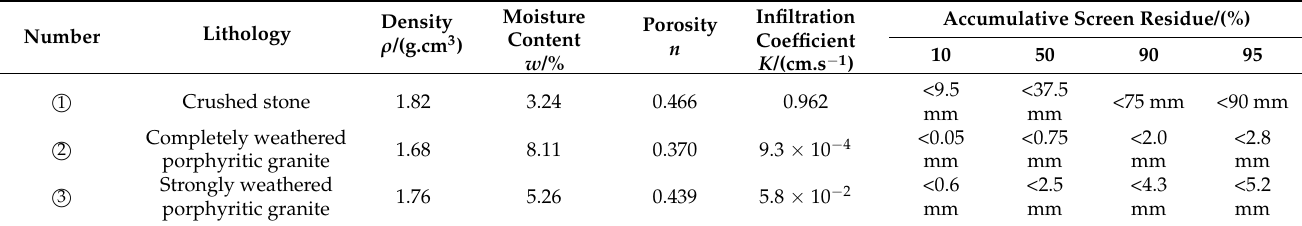
Table 1. Basic parameters of grouting stratum rock and soil mass.